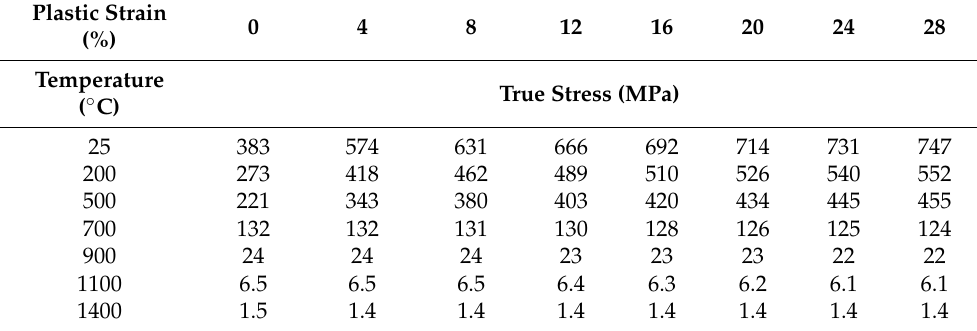
Table 13. Flow stress of ER309L at different temperatures.